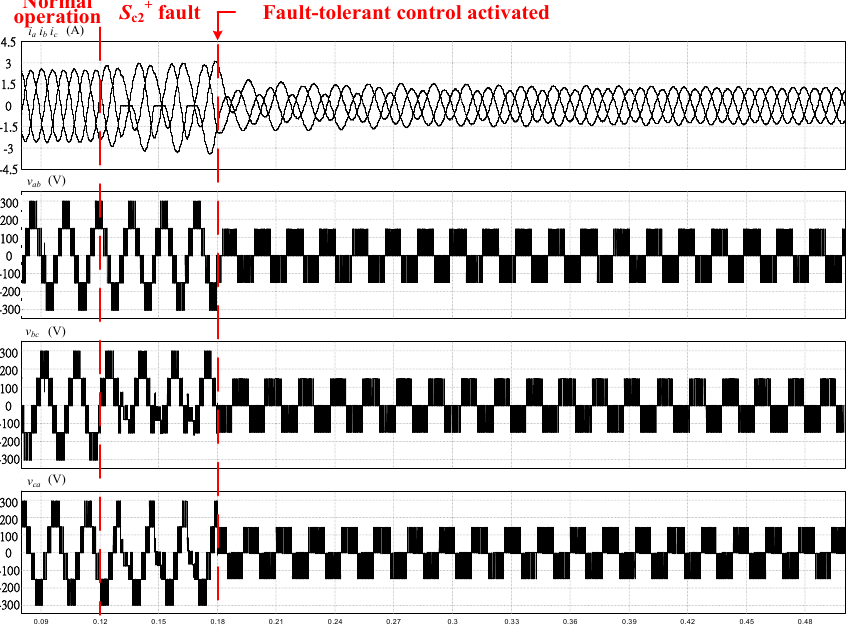
Figure 18. Waveforms of the output line voltage and line current of internal switch S c 2 + with an open-circuit fault and tolerant control.